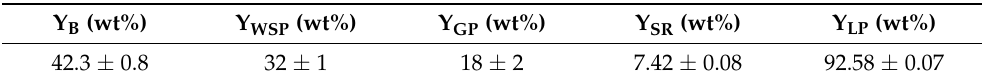
Table 4. Experimental yields at the optimum conditions (320 ◦ C, 10 min and 10 wt% biomass concentration) for N. gaditana